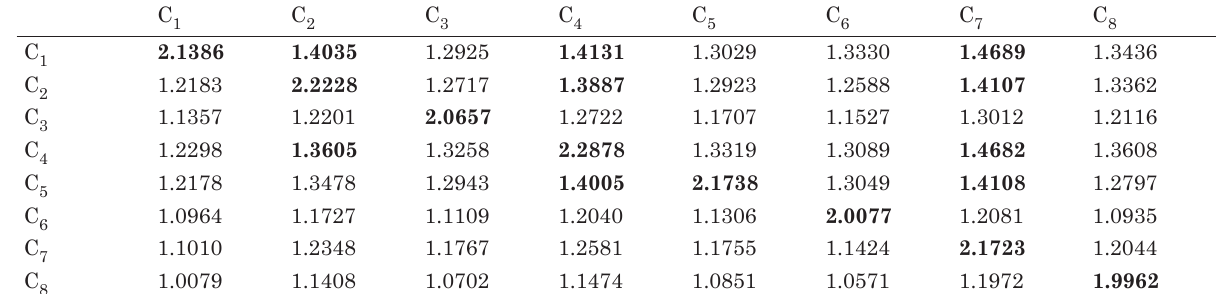
Table 8. Matrix T